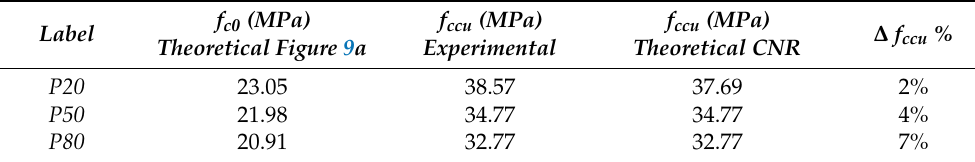
Table 4. Prediction of the CNR model with modified f c0